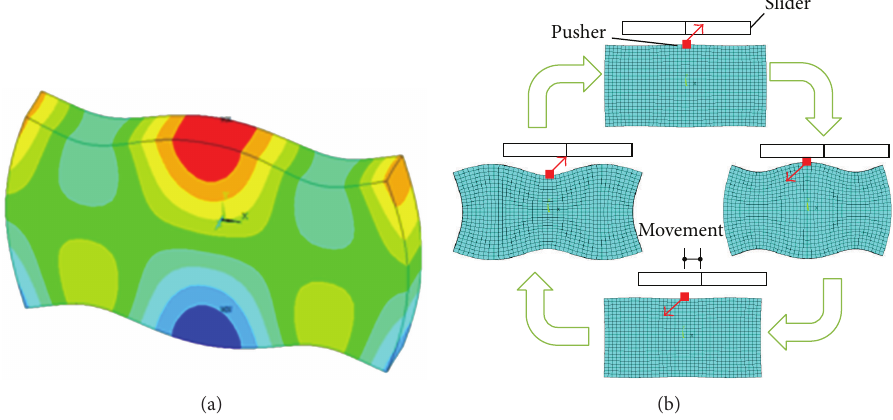
Figure 1: (a) Vibration mode of actuator using a single pusher. (b) Driving principles of the actuator.